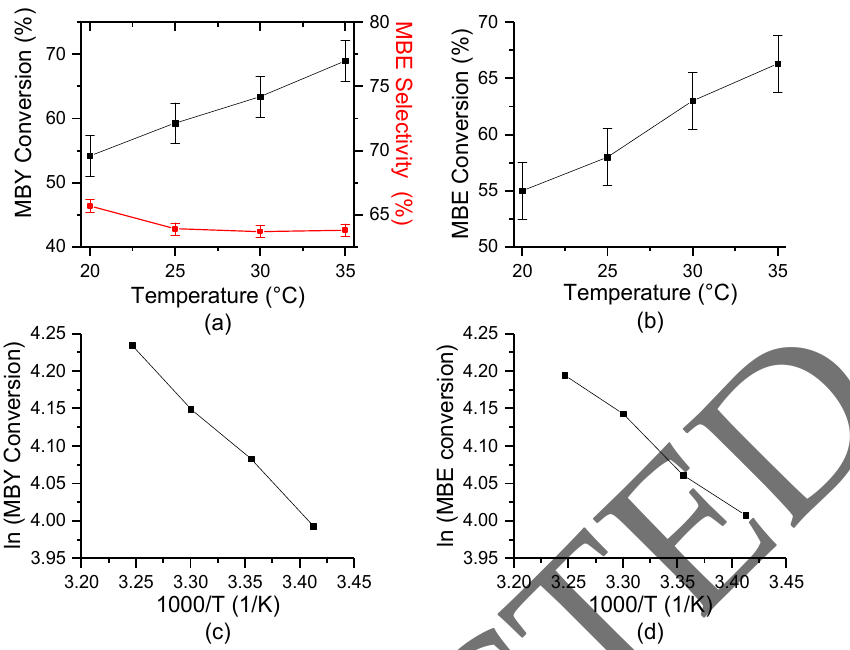
Figure 4. ( a ) Conversion of MBY and MBE with temperature; ( b ) conversion of MBE with temperature; ( c ) Arrhenius plot for MBY conversion; ( d ) Arrhenius plot for MBE conversion.